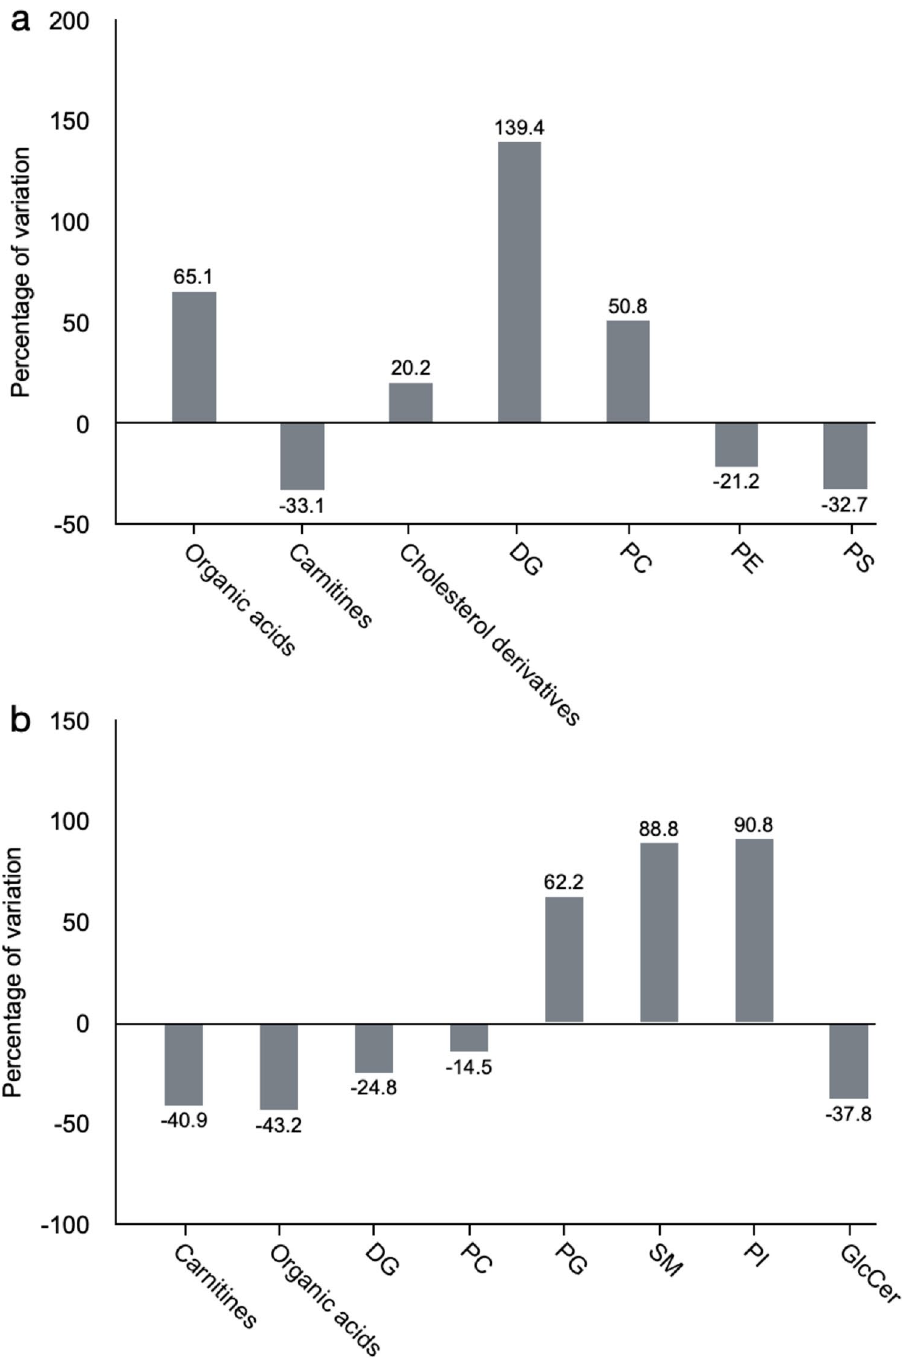
Figure 6. Average percentage of variation for relevant groups of metabolites changed in the different studied groups. ( a ) Percentage of variation of metabolic groups between Ptn -Tg mice and Wt mice injected with 6-OHDA. ( b ) percentage of variation of metabolic groups between Ptn -Tg mice and Wt mice injected with the vehicle. DG: Diglyceride, PC: Phosphatidylcholine, PE: Phosphatidylethanolamine, PS: Phosphatidylserine, PG: Phosphatidylglycerol, SM: Sphingomyelin, PI: